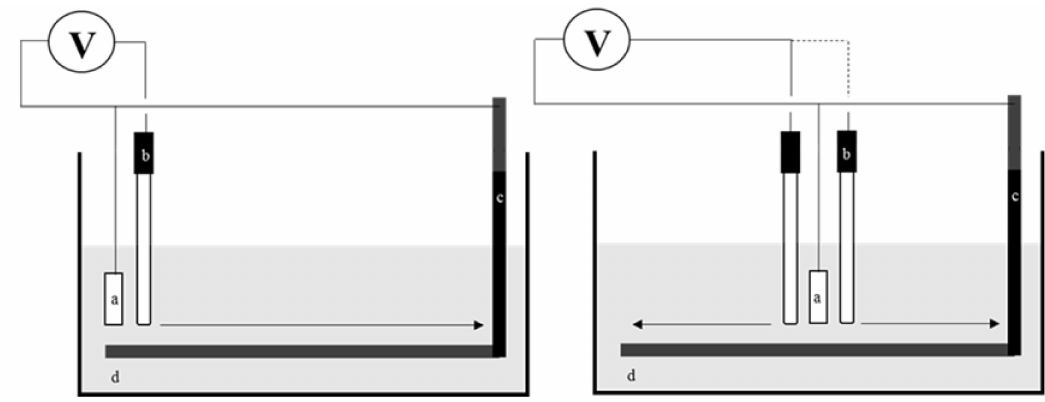
Figure 4. Experimental setup showing two configurations (sacrificial anode at the edge and in the middle of the cathode). Legend: ( a ) zinc sacrificial anode; ( b ) Ag/AgCl reference electrode; ( c ) cathode; ( d )